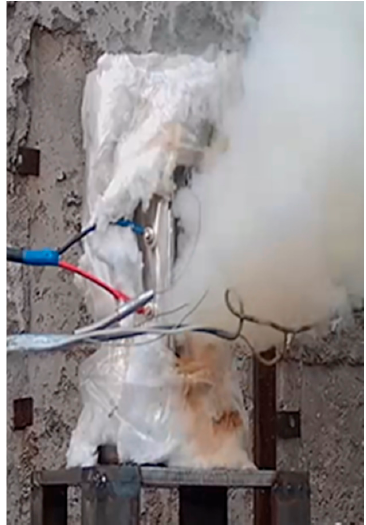
Figure 2. Jetting smoke.